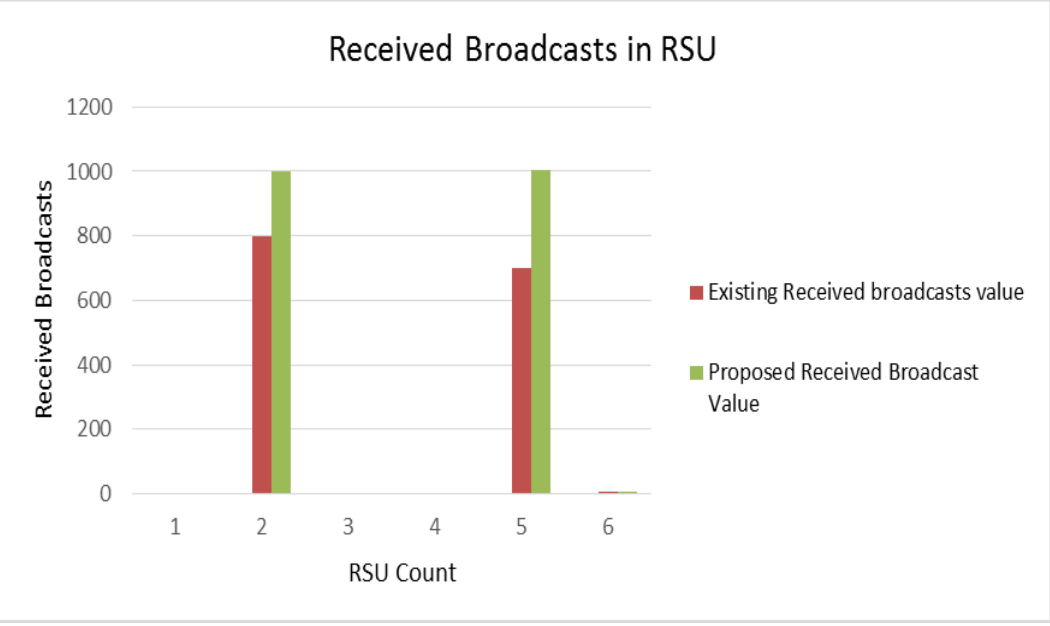
Figure 15. Received Broadcasts in